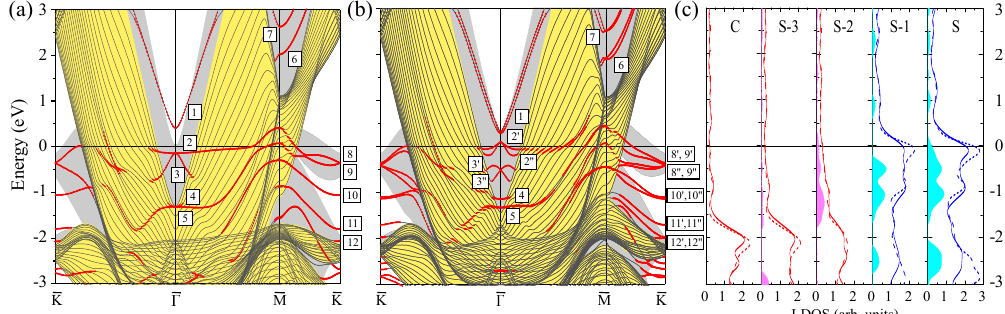
Figure 8. The electronic structure of the 2 ML-Pt/Au(111) surface calculated without ( a ) and with ( b ) spin–orbit interaction. The surface and quantum-well states and resonances are indicated by red dots. The states discussed in the text are labeled by symbols. In ( c ), the layer density of states is shown for two Pt, top two and central Au atomic layers. Blue and pink regions show the excess of LDOS in, respectively, Pt and Au layers in comparison with the corresponding bulk values.